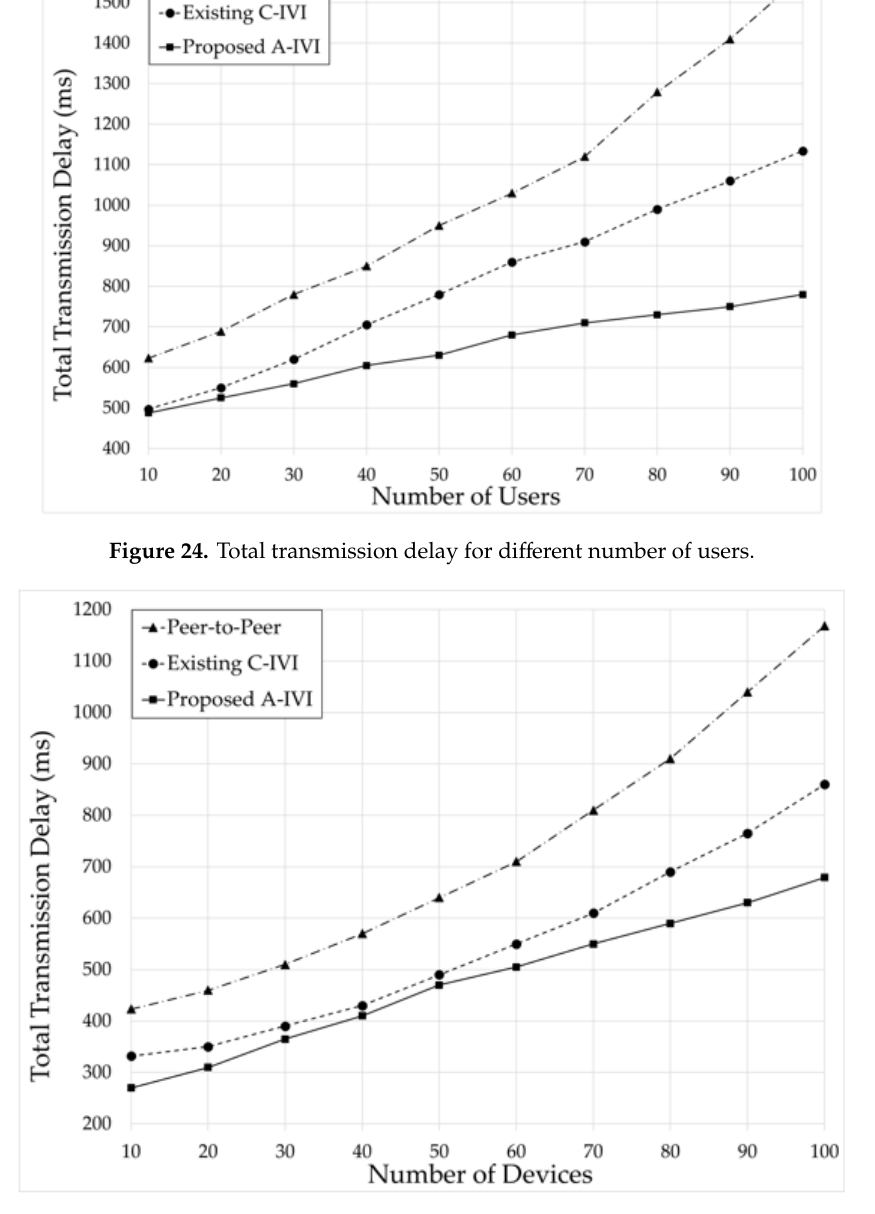
Figure 25. Total transmission delay for different number of devices.